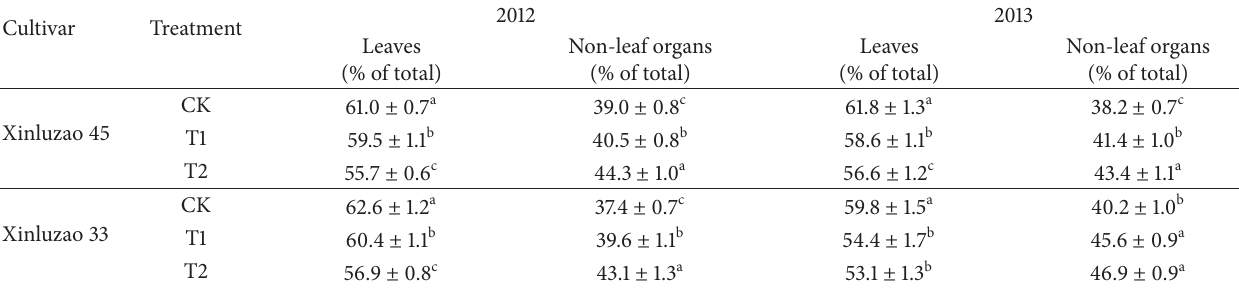
Note: Values represent the average surface area between the full flower and the full boll stages. Comparing water treatments within a cultivar, values within a column followed by different letters are significantly different at the 0.05 probability level. Values are means ± SD of three replicates. Abbreviations: CK: conventional irrigation; T1: slight deficit irrigation; T2: moderate deficit